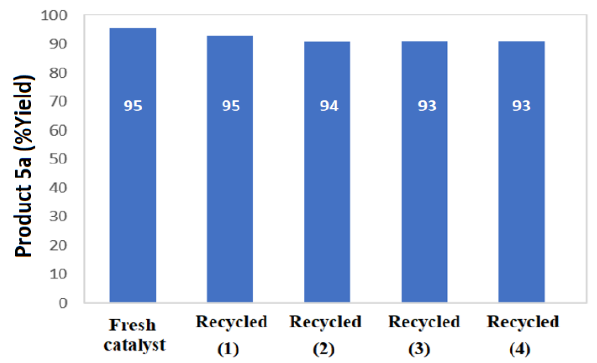
Figure 7. Recyclability of CS-SrO nanocatalyst in synthesis of product 5a .